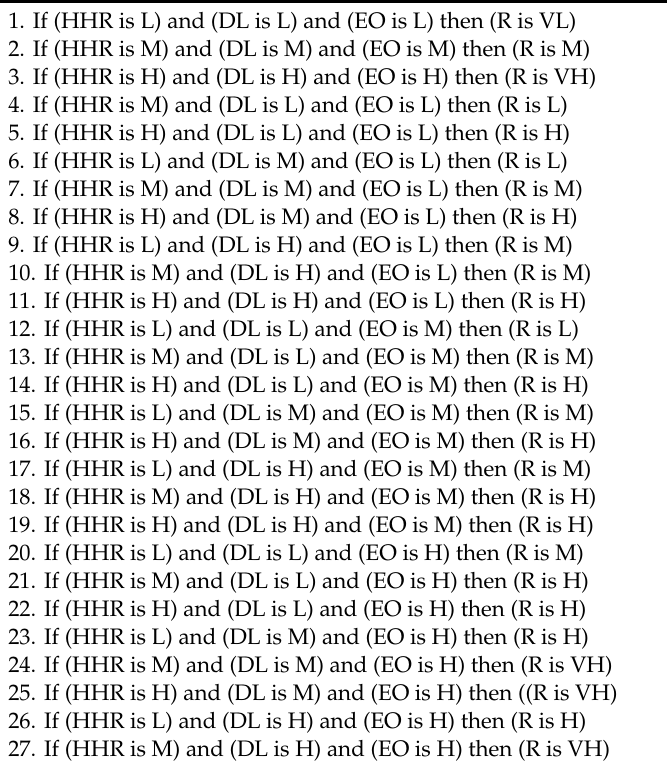
Table 4. Rules defined for the FIS sub-model used to estimate Resilience levels (R). HHR = Human Health Resources, EO = Emergency Operability, DL = Development Level. Antecedent’s membership functions: H = high, M = medium, L = low. Consequent’s membership functions: VH = Very High, H = High, MH = Medium-High, ML = Medium-low, L = Low.